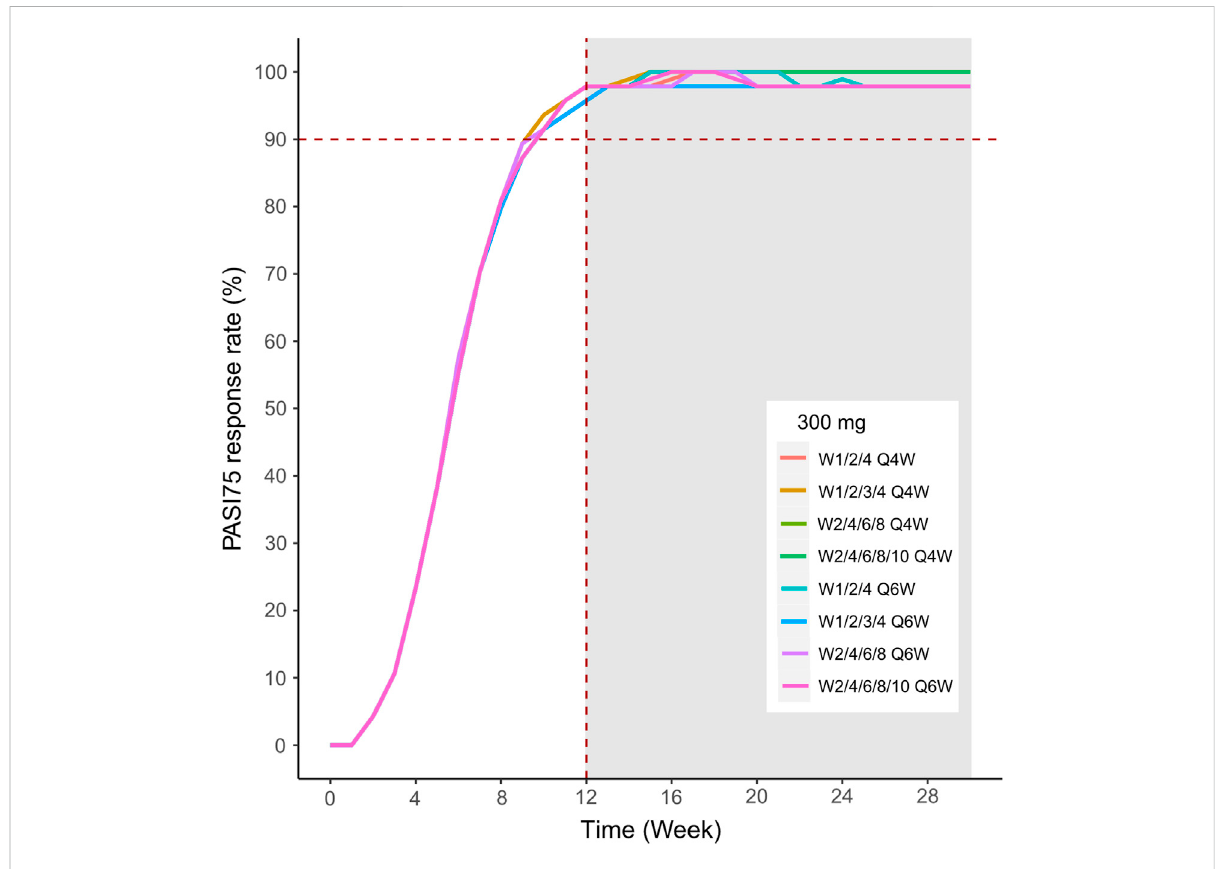
FIGURE 12 Simulated median PASI75 and PASI90 response rates under different dose regimens using the fi nal population PK/PD model. The PASI75 response rate of 300 mg in eight dosing